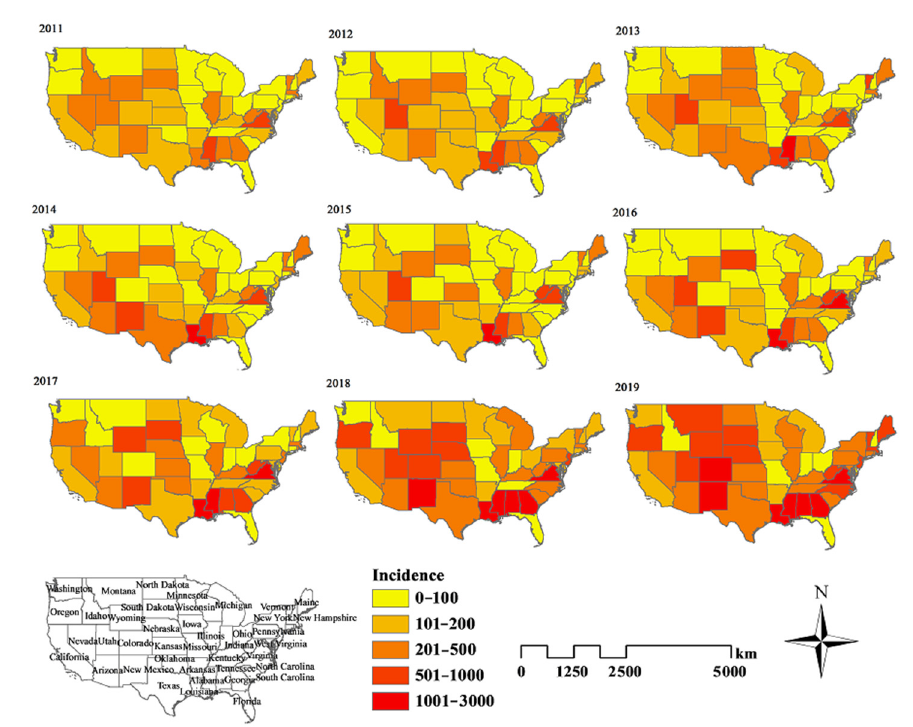
Figure 3. Maps of ILI incidence for each state in the United States from 2011 to 2019 by ArcGIS software.